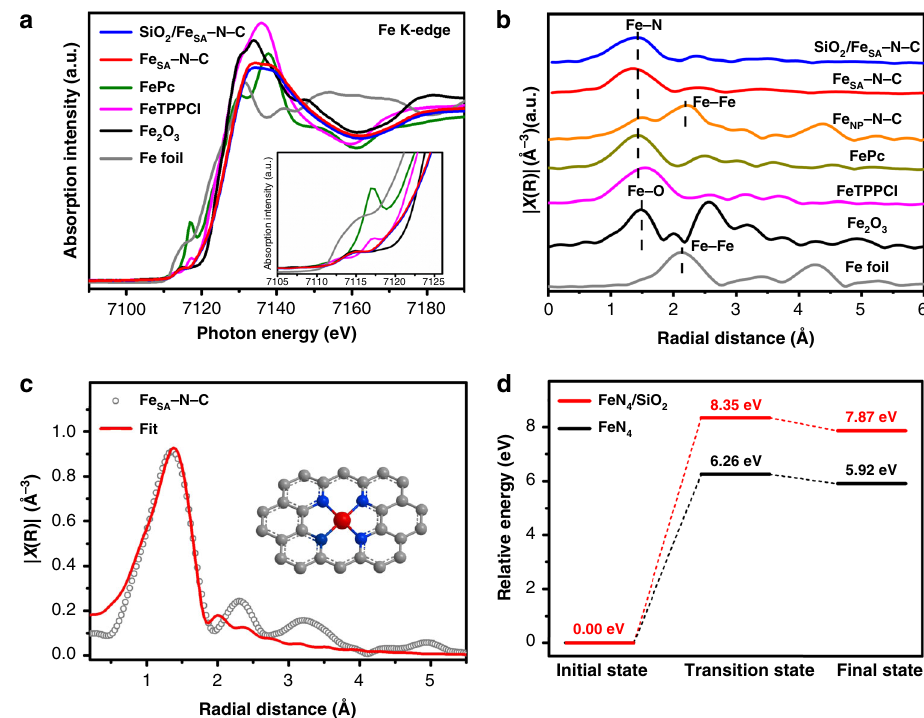
Fig. 3 Structure characterizations and DFT calculations. a Fe K-edge XANES and b FT-EXAFS spectra of SiO 2 /Fe SA – N – C, Fe SA – N – C, and Fe NP – N – C (represented by blue, red, and orange lines, respectively). c EXAFS fi tting for Fe SA – N – C (red line: fi tting curve; gray cycles: experimental data). Inset: schematic model of Fe coordination environment in Fe SA – N – C. The red, blue, and gray spheres represent Fe, N, and C atoms, respectively. d The relative energy along the intrinsic reaction coordinate for FeN 4 /SiO 2 (red line) and FeN 4 (black line) migrating from initial state to fi nal